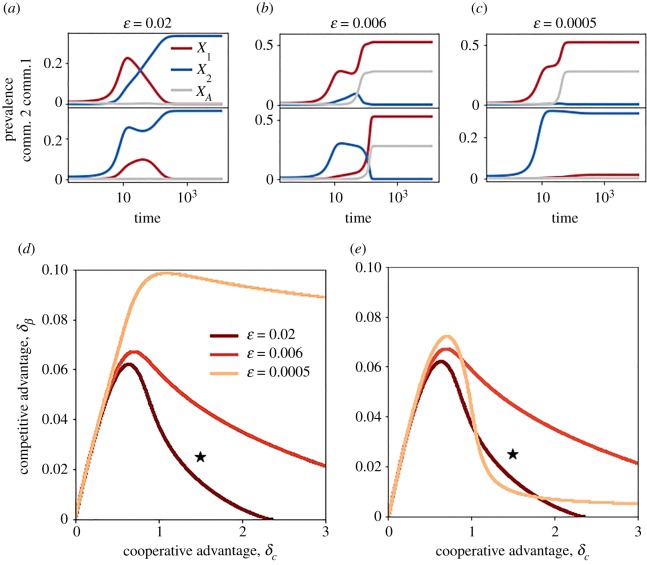
Role of spatial separation for two interacting communities. (a–c) Dynamical trajectories within communities 1 and 2 obtained for (a) ε = 0.02, (b) ε = 0.006 and (c) ε = 0.0005. (d,e) Boundaries in the δc, δβ plane delimiting the regions where the dynamics ends up in (d) B1 persistence (i.e. [A&B1] or full coexistence); (e) [A&B1] state. In all panels, A and B1 are seeded together into one community, while B2 is seeded into the other community; the initial density of each species is set to 0.01. Trajectories are obtained by setting δc = 1.5, δβ = 0.025 (black star in (d,e)). Other parameters are as in figure 2a.